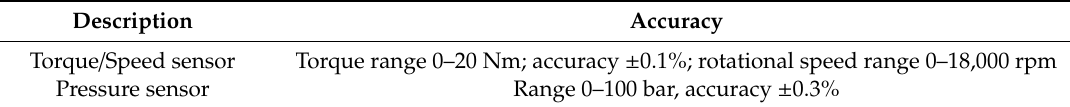
Figure 16. Experimental schematic diagram. Table 2. Details of the relevant sensors.